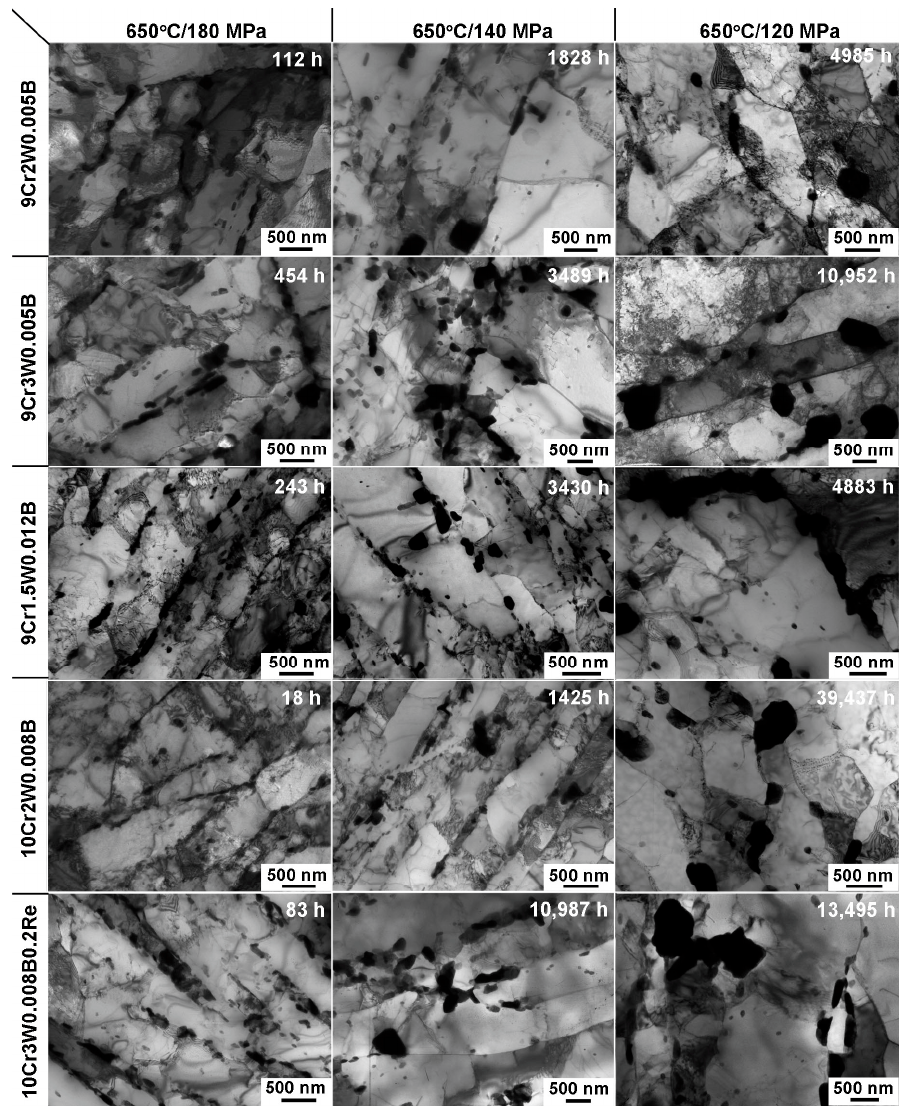
Figure 5. TEM images of all steels studied after some creep rupture tests corresponding to the regions of short-term creep (180 MPa), transition creep (140 MPa), and long-term creep (120 MPa). Numbers indicate the rupture time for each creep test. The black and grey particles correspond to Laves phase and M 23 C 6 carbides, respectively.